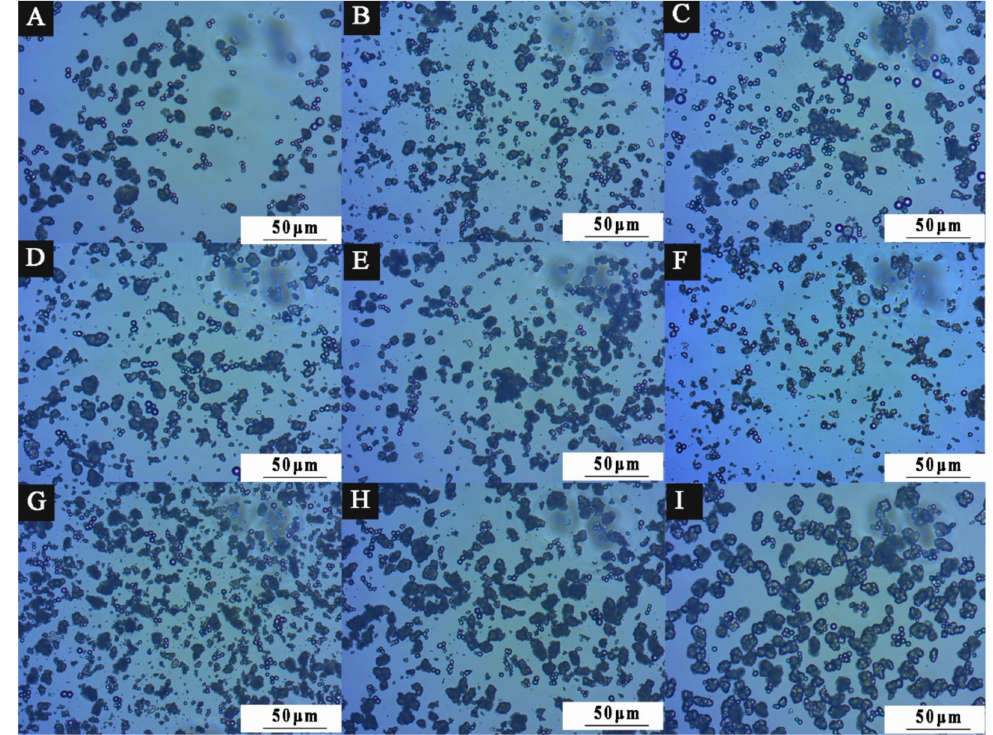
Figure 4. OM diagram of orthogonal experiment of 9 groups of microcapsules: ( A ) 1#, ( B ) 2#, ( C ) 3#, ( D ) 4#, ( E ) 5#, ( F ) 6#, ( G ) 7#, ( H ) 8#, ( I ) 9#.